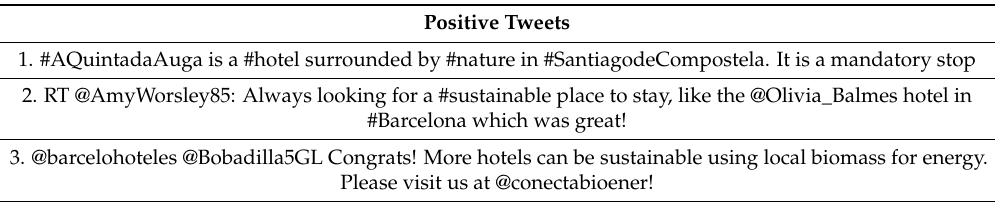
Table 13. Positive tweets